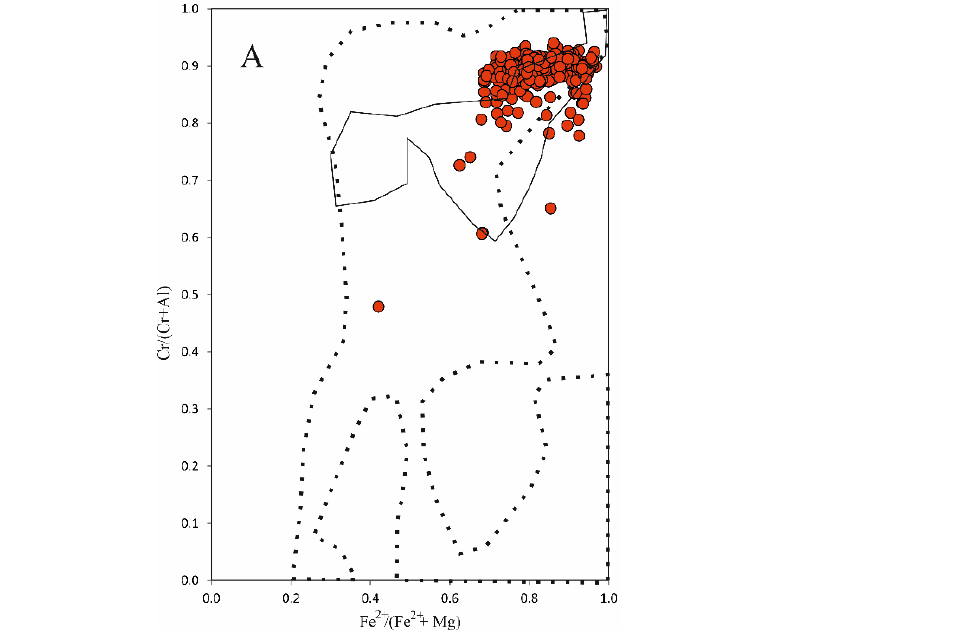
Figure 4. Cr/(Cr + Al) vs. Fe 2+ /(Fe 2+ + Mg) for the spinels and alkaline basalts studied here; lampro- phyres, related rocks [11] (dotted line), and Alaskan ultramafic complexes [11] (continuous line).